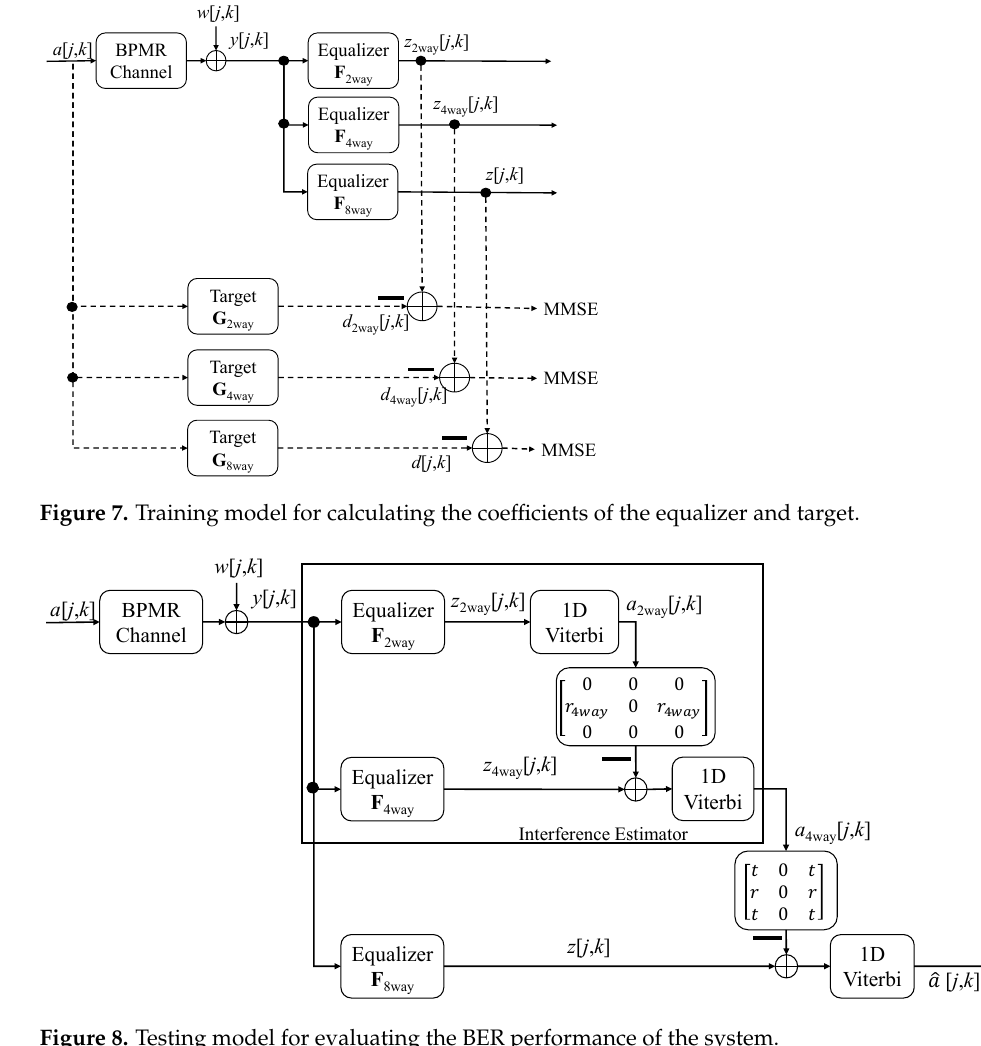
Figure 8. Testing model for evaluating the BER performance of the system.